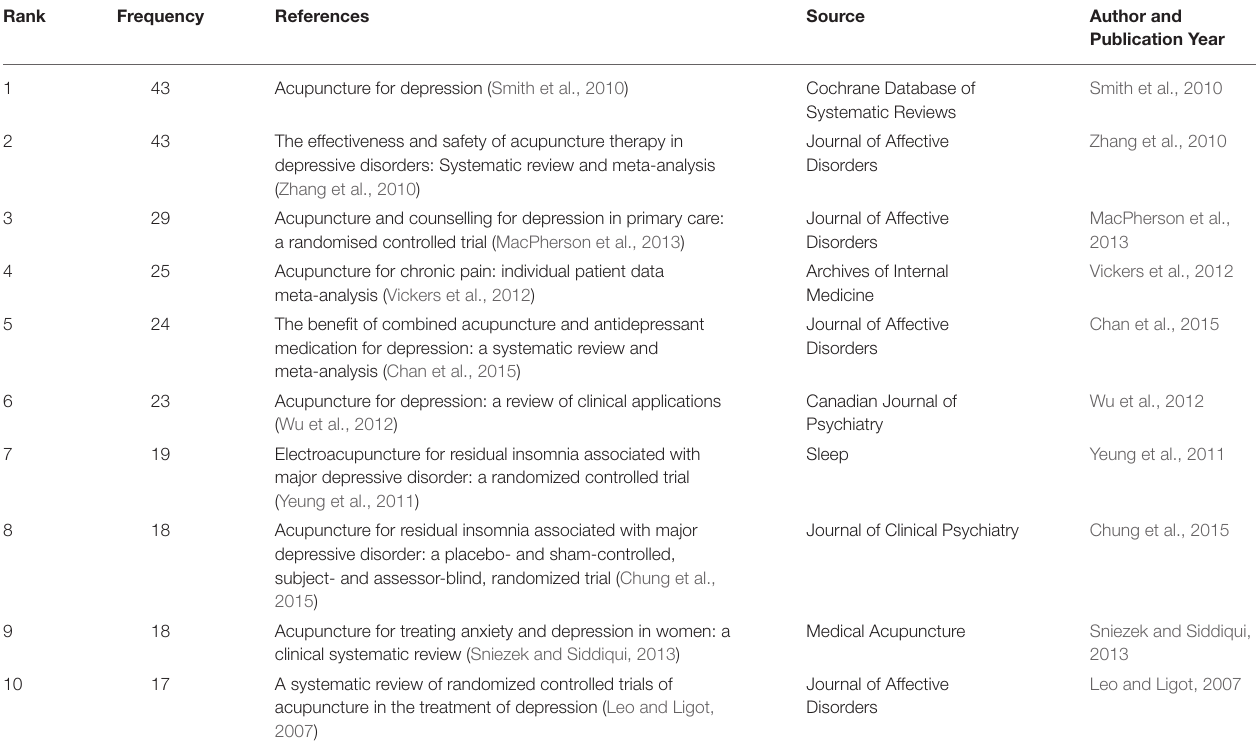
TABLE 6 | Top 10 frequencies of cited references related to acupuncture on depression.